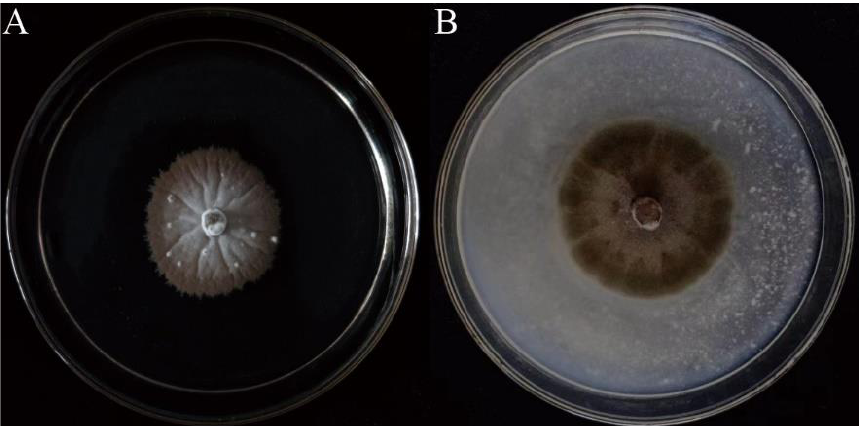
Figure 1. Colonies of strain SGSF723. ( A ) The 5-week-old colony on the PDA. ( B ) The 2-week-old colony on the OA.